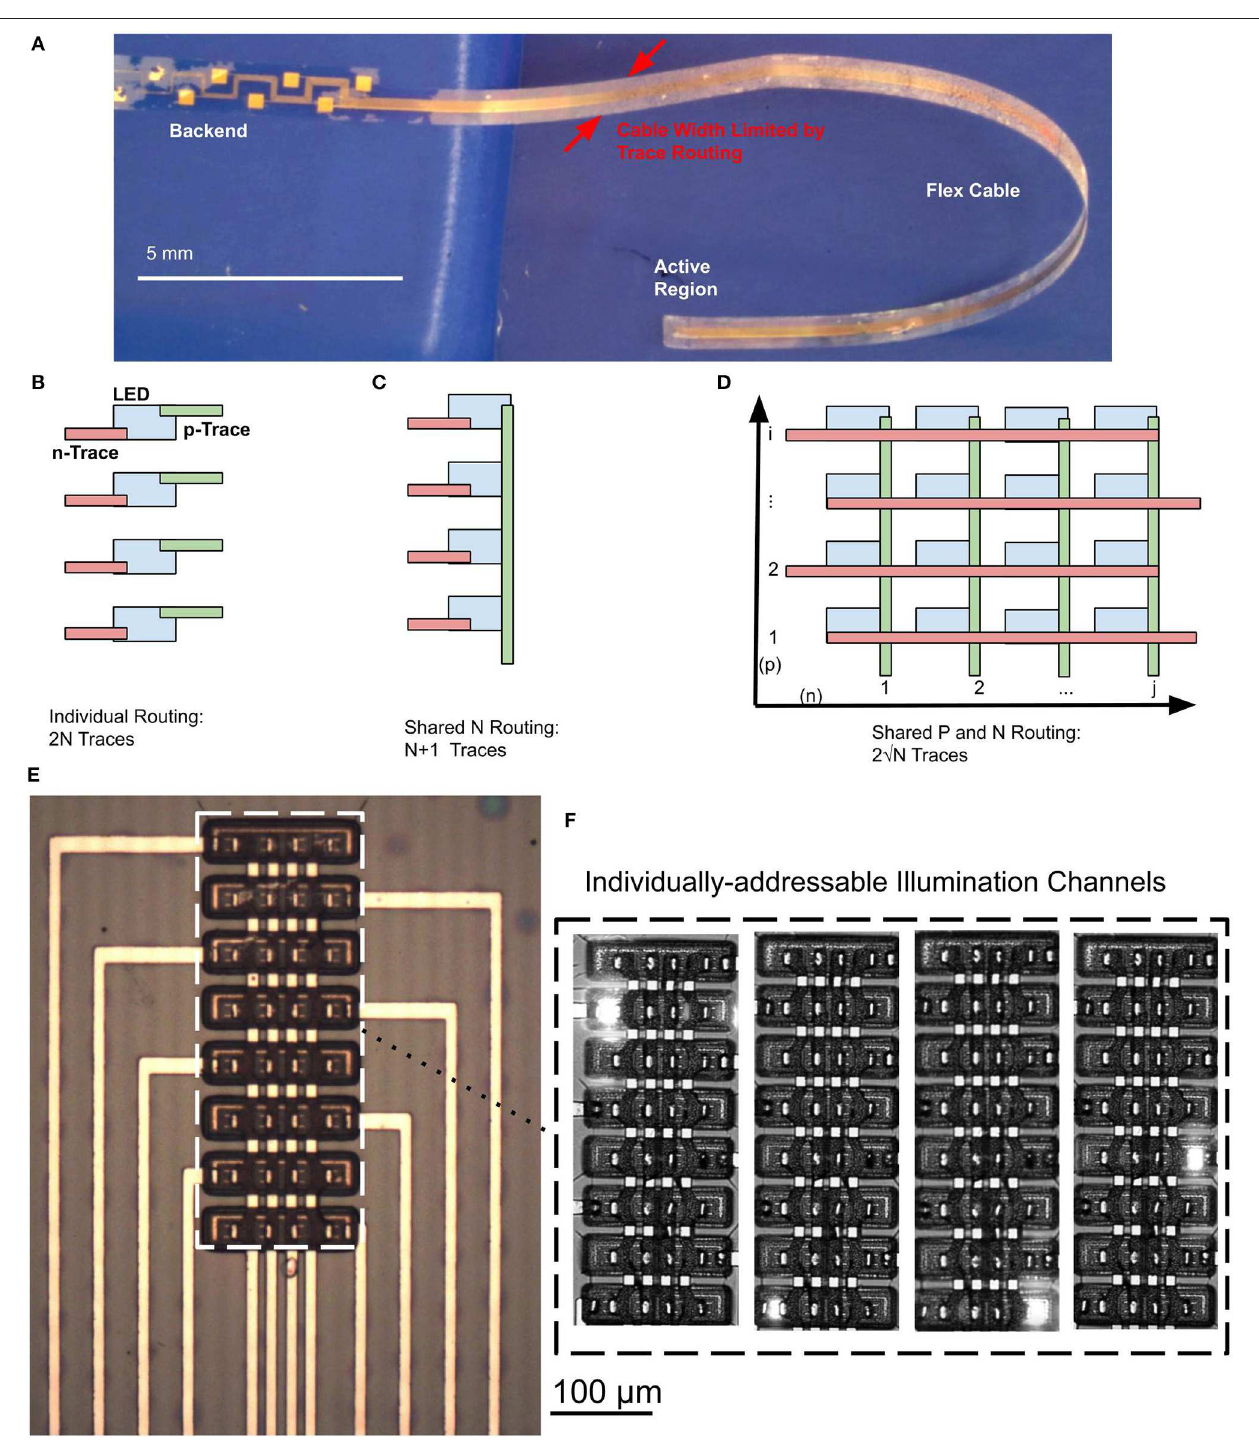
FIGURE 2 | (A) Released, flexible 2.1-cm Parylene C cable with embedded µ LEDs. Cable dimensions are constrained by the number of traces that needs to be routed in a single layer. (B) Trace routing scheme when each µ LED has a dedicated electrical trace for the p -type and n -type contacts, resulting in 2N total traces. (C) Trace routing scheme where a linear array of µ LEDs share n -type contacts, resulting in N + 1 total traces. (D) Trace routing scheme where a 2D array of µ LEDs share traces for p -type and n -type contacts, resulting in only 2 √ N traces. This routing scheme cannot be achieved in a single routing layer, as trace intersections will short the p -type and n -type traces. (E) Microscope image of 2D µ LED array. (F) Illumination patterns of µ LED array showing individual addressability in the 2D routing scheme.